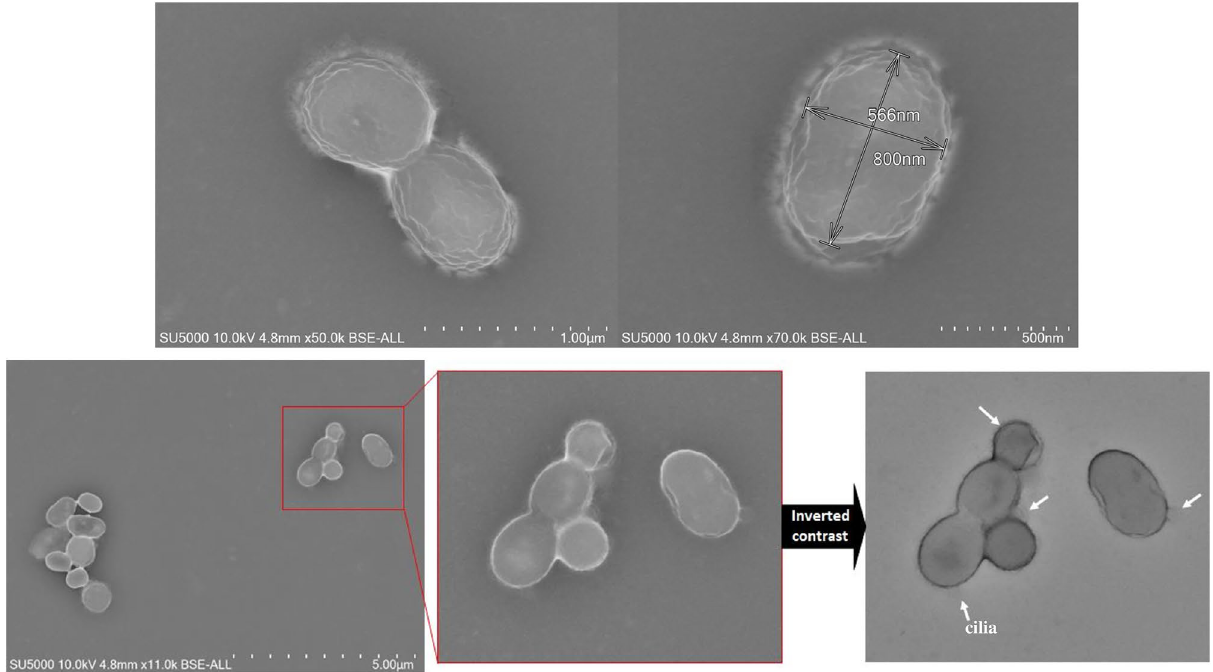
Figure 1. Transmission electron microscopy of Akkermansia massiliensis strain